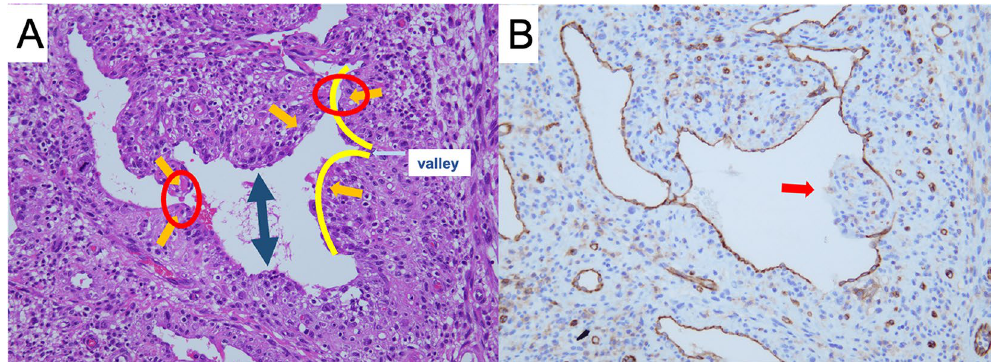
Figure 4. ( A ) Sickle-shaped blood vessels as observed after H&E staining. Possibly, due to weak vascular support structures, irregular stenosis (red circle) caused by surrounding tumor cell growth (orange